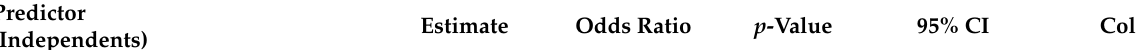
Table 7. Multivariate logistic regression. The independent variables only associated with the 16-P- CPQ and 4-FIS dichotomized scores ( p <